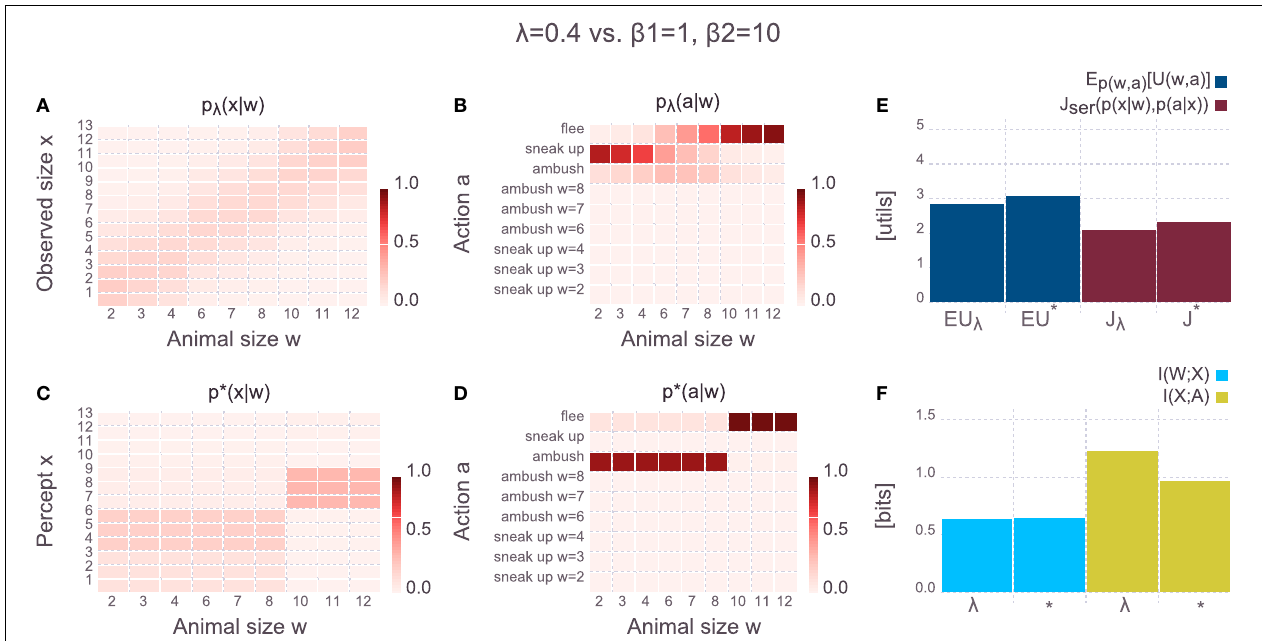
FIGURE 8 | Comparing hand-crafted perception against bounded-optimal perception (parameters are given above the panels) . Compared to Figure 6 , the perceptual channel of both the hand-crafted and the bounded-optimal system now has low computational resources (through the low (cid:21) and (cid:12) 1 respectively). (A) Hand-crafted perceptual model p (cid:21) ( x | w ) [equation (20)] – due to the low precision (cid:21) , the noise for the hand-crafted perception has increased dramatically. (B) Overall-behavior of the system p (cid:21) ( a | w ) [equation (21)] with the hand-crafted perception. Even though the action-part of the system still has large